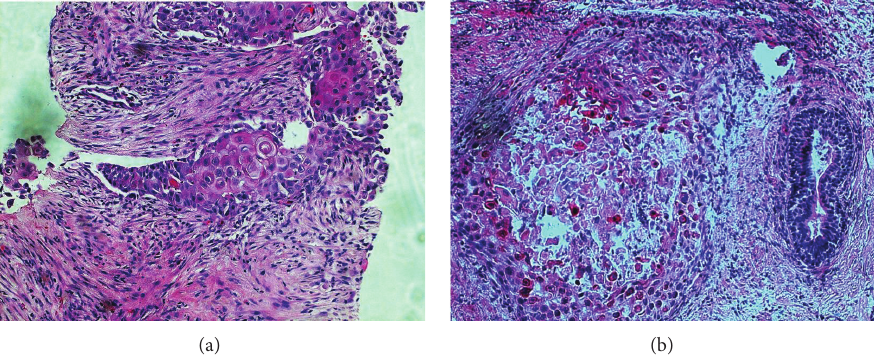
Figure 2: (a) Tumor cells with atypical, pleomorphic nuclei, prominent nucleoli, and cytoplasmic keratotic features infiltrating prostatic stroma (HEx200). (b) Tumor island with central necrosis is seen near a prostatic duct